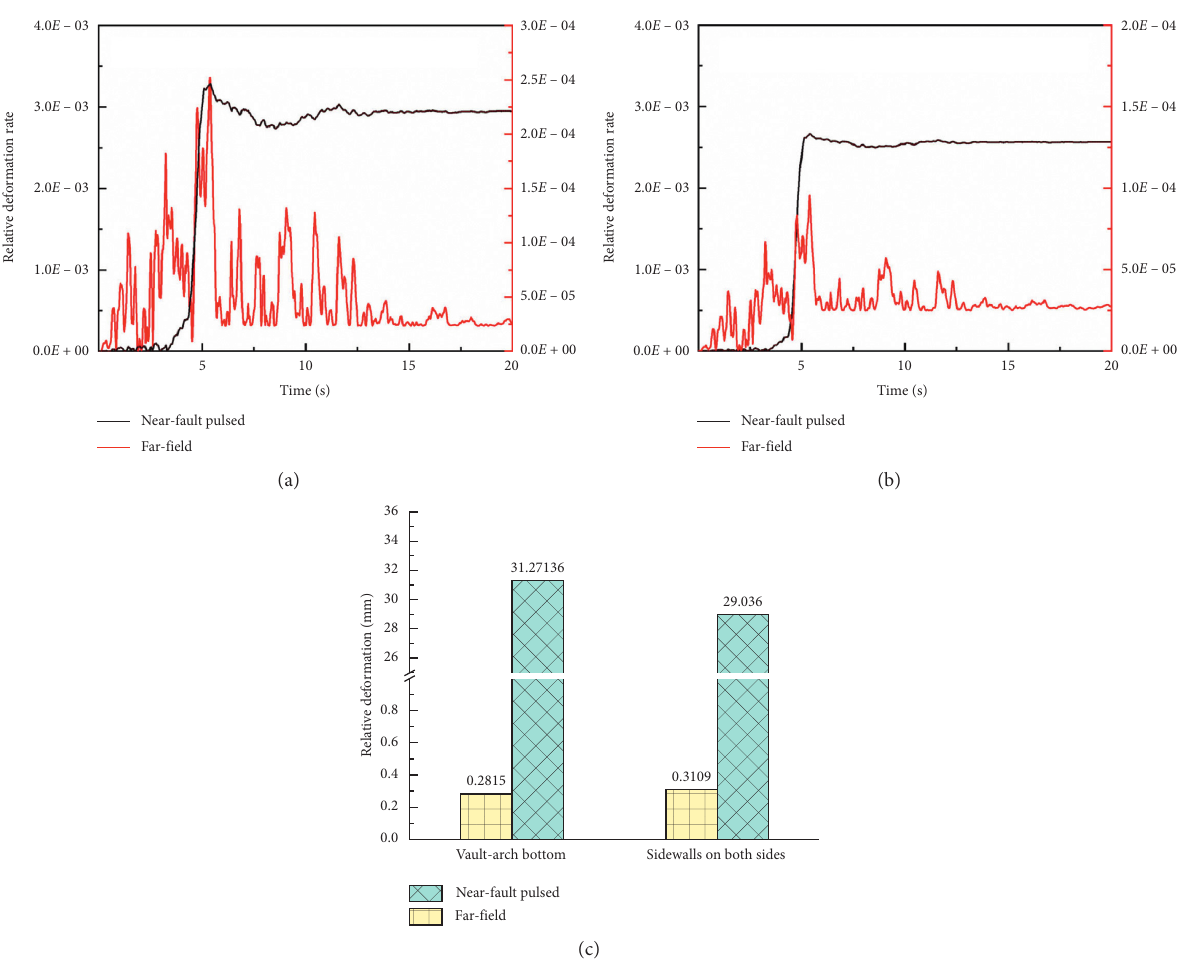
Figure 4: Relative deformation of the tunnel structure under different action of ground motions. (a) The relative deformation rate of the vault-arch bottom of the tunnel structure. (b) The relative deformation rate of the sidewalls on both sides of the tunnel structure. (c) The comparison of the relative deformation of the vault-arch bottom and the sidewalls on both sides.